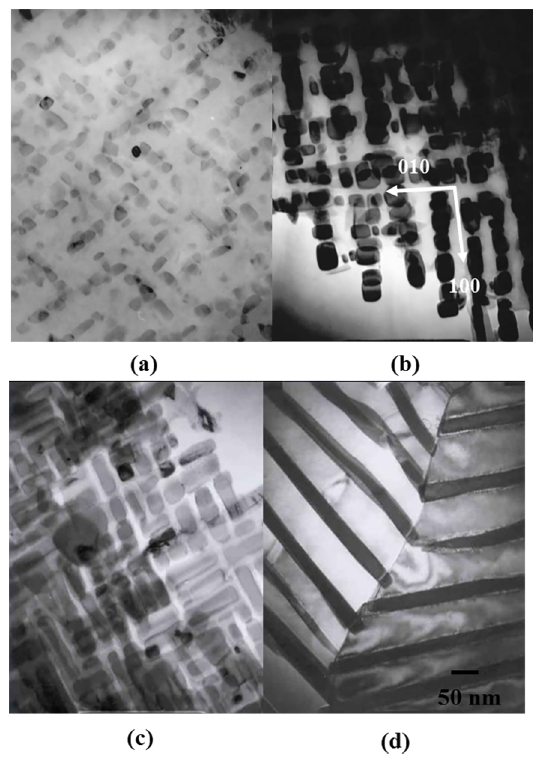
Figure 3. BF-TEM micrographs of Cu-4wt.%Ti alloy aged at 600 °C for (a) 0.0166 h, (b) 0.166 h, (c) 1 h and (d) 5 h.